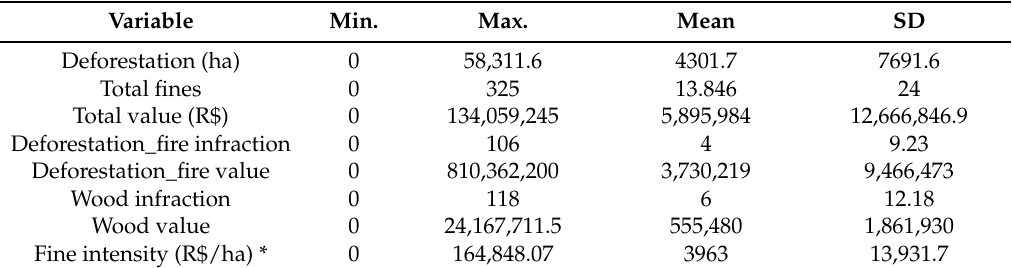
Figure 4. Fines in study area in Mato Grosso. Table 2. Summary statistics for fines in study area in Mato Grosso.